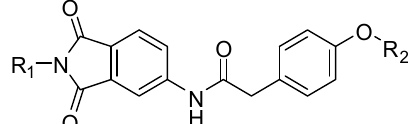
Figure 4. Sites of modification R 1 and R 2 .